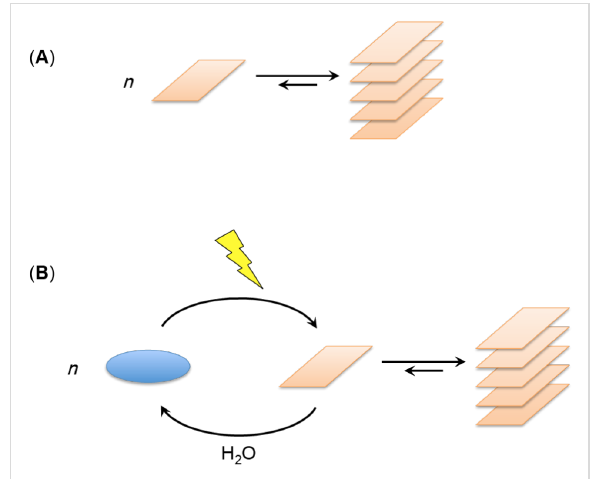
Figure 1: Self-assembly. (A) Macromolecular structures or patterns can form as the result of binding energy being released through the interaction of units which compensates for the decrease in entropy as- sociated with self-organisation. (B) An example of dissipative self- assembly of reactants unable to react in the ground state but which can be activated to yield unstable reactive units (e.g., susceptible to hydrolysis). The supramolecular structure is dynamically stable as long as the system is held far from equilibrium through the energy-fuelled supply of reactive